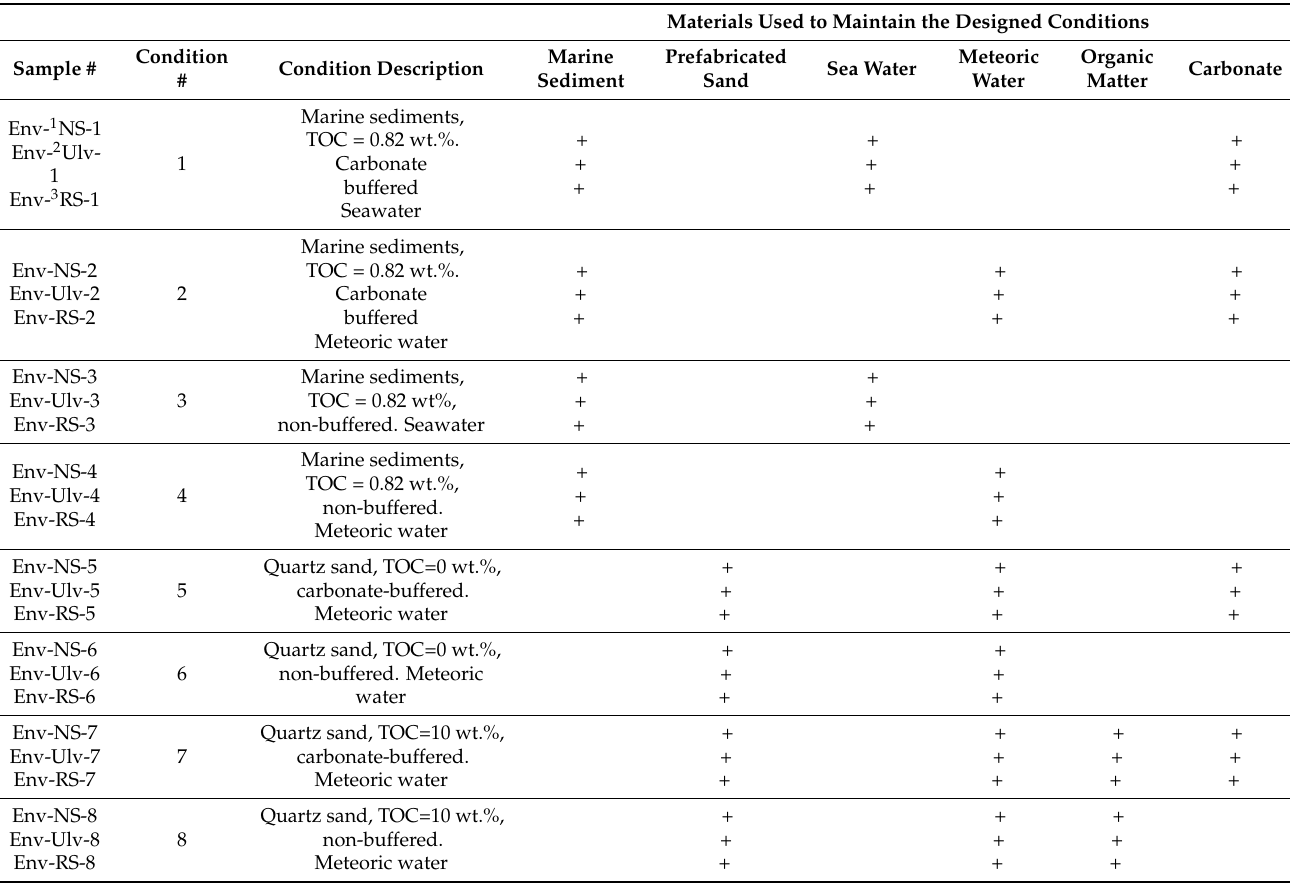
Table 1. Experimental setups. The cross mark corresponds to the ingredient added to the composition of the mixture. Sample last digits correspond to the experiment setup